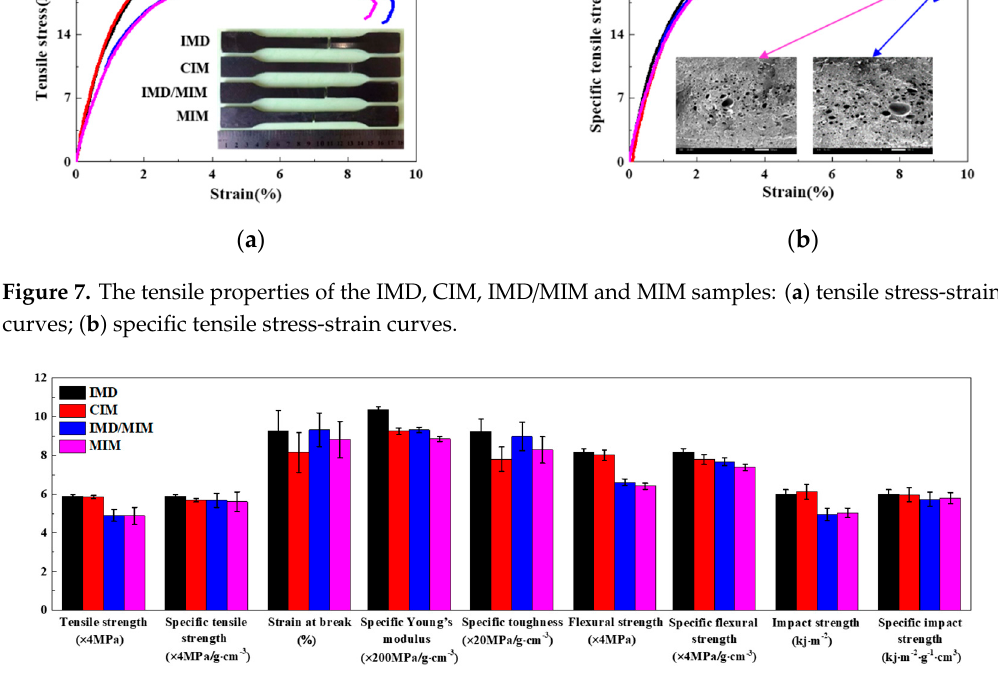
Figure 8. Comparison of mechanical properties among the IMD, CIM, IMD/MIM and MIM samples (the error bars in the figure represent the standard deviation).